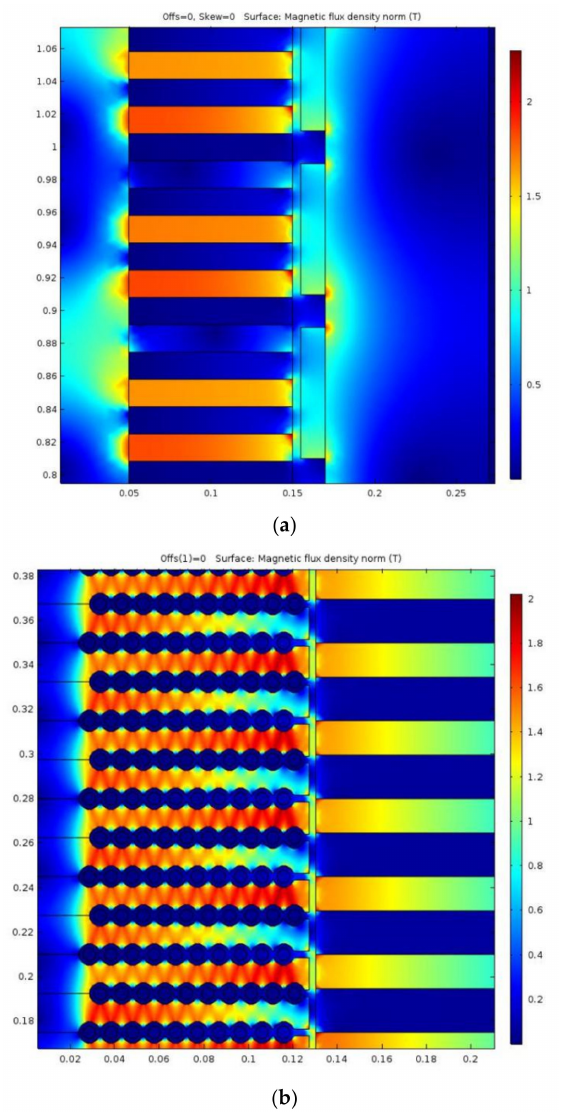
Figure 11. FEA calculations for two of the reference machines: ( a ) Machine B, the neodymium magnet generator made by Polinder et al., simulated with a current rating of 2.5 A/mm 2 ; and, ( b ) Machine C, the ferrite generator designed and built by the Uppsala group, simulated with a current rating of 1.5 A/mm 2